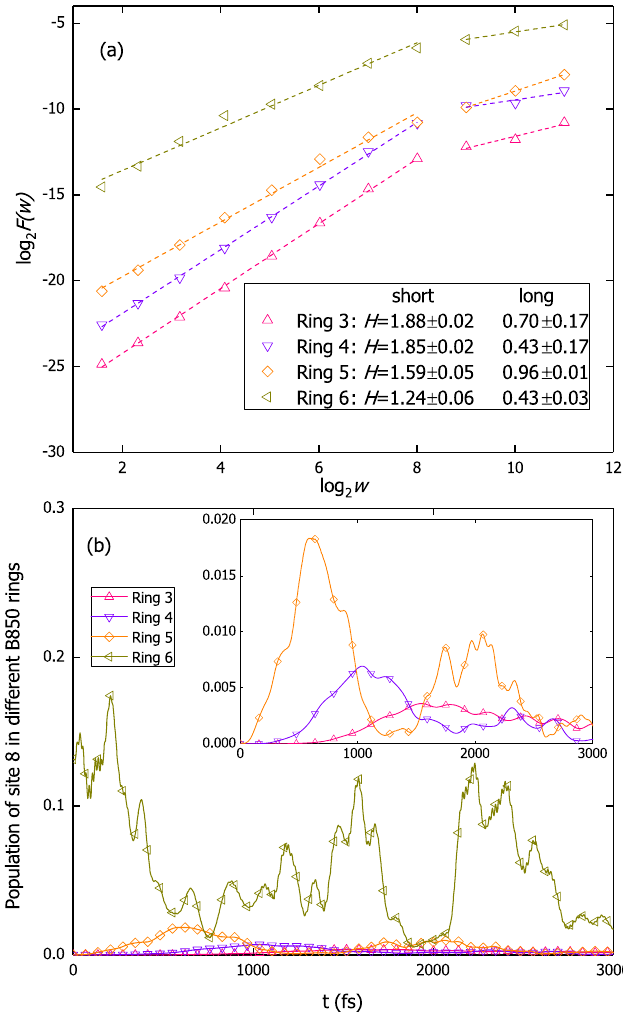
Figure 6. ( a ) Results of the adaptive fractal analysis for the population dynamics of site 8 in different B850 rings. The dashed lines in ( a ) are the linear fitting curves with the slopes (Hurst parameter H ) shown in the legend. ( b ) Exciton populations on site 8 in four rings (rings 3, 4, 5, and 6). The simulation is carried out for a B850 chain containing 11 rings and initially the central ring (ring 6) is excited to its second lowest exciton state. The insert in ( b ) is the enlarged plot of the population on site 8 in rings 3, 4, and